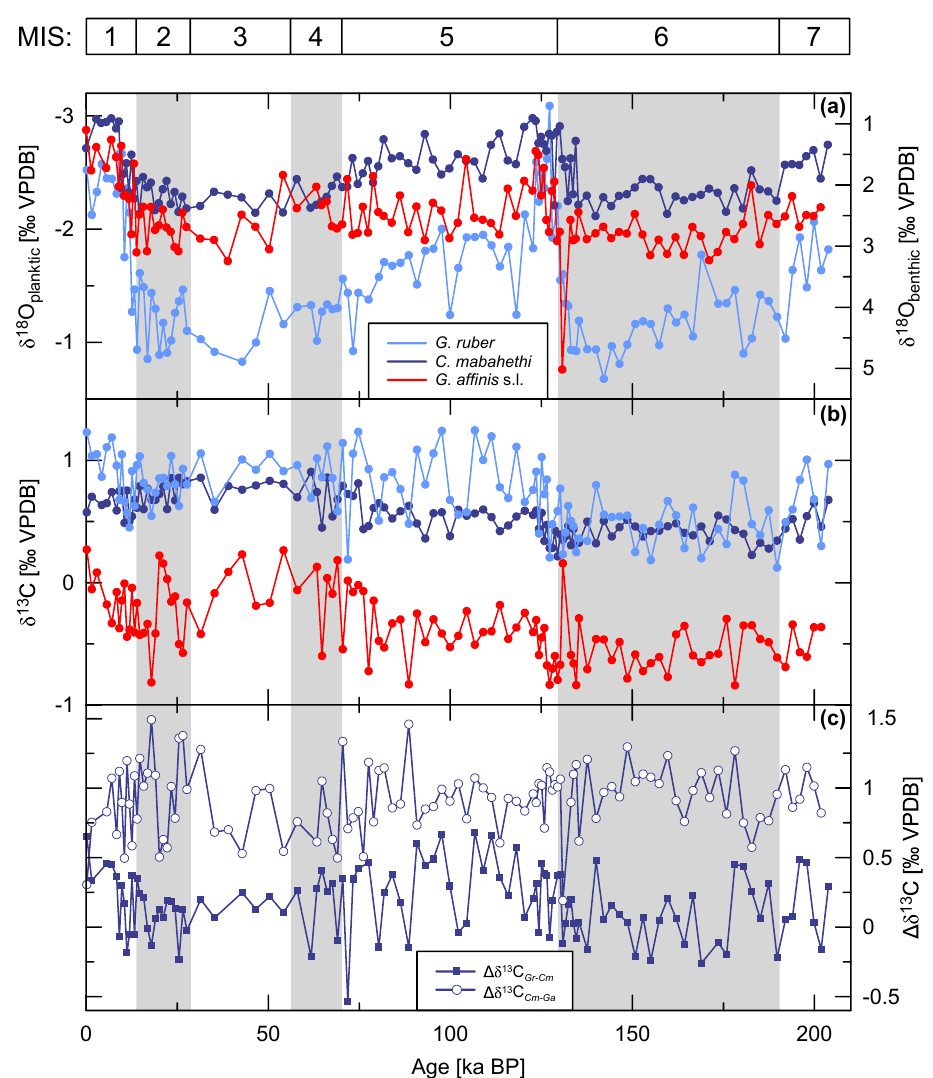
Figure 3. (a, b) Stable oxygen and carbon isotope records of planktonic and benthic foraminifera in sediment core SO236-052-4. Displayed are the planktonic species G. ruber (light blue), the epibenthic species C. mabahethi (dark blue) and the deep infaunal species G. affinis s.l. (red). Also shown are the full-resolution data of the (cid:49)δ 13 C Gr - Cm and (cid:49)δ 13 C Cm - Ga signals (c) as a result of the difference between the (cid:49)δ 13 C values of G. ruber and C. mabahethi , as well as C. mabahethi and G. affinis s.l. MIS denotes the marine stable oxygen isotope